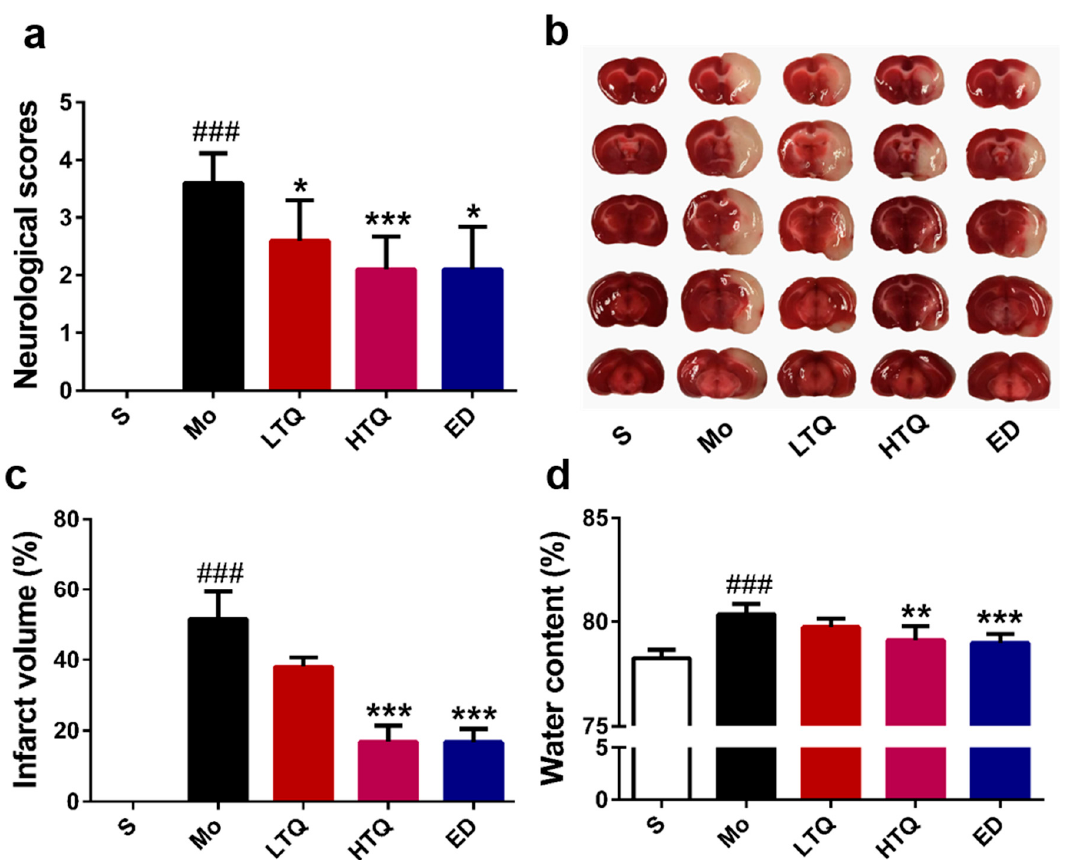
Protective e ff ect of thymoquinone in a rat model of cerebral ischemia reperfusion injury. ( a ) Neurological deficit scores ( n = 10), ( b ) Representative images of triphenyltetrazolium chloride-stained brain sections, ( c ) Infarct volume percentage ( n = 6), ( d ) Brain water content ( n = 6). Data are expressed as mean ± SD, ### p < 0.001 vs. sham group; * p < 0.05, ** p < 0.01, *** p < 0.001 vs. model group.